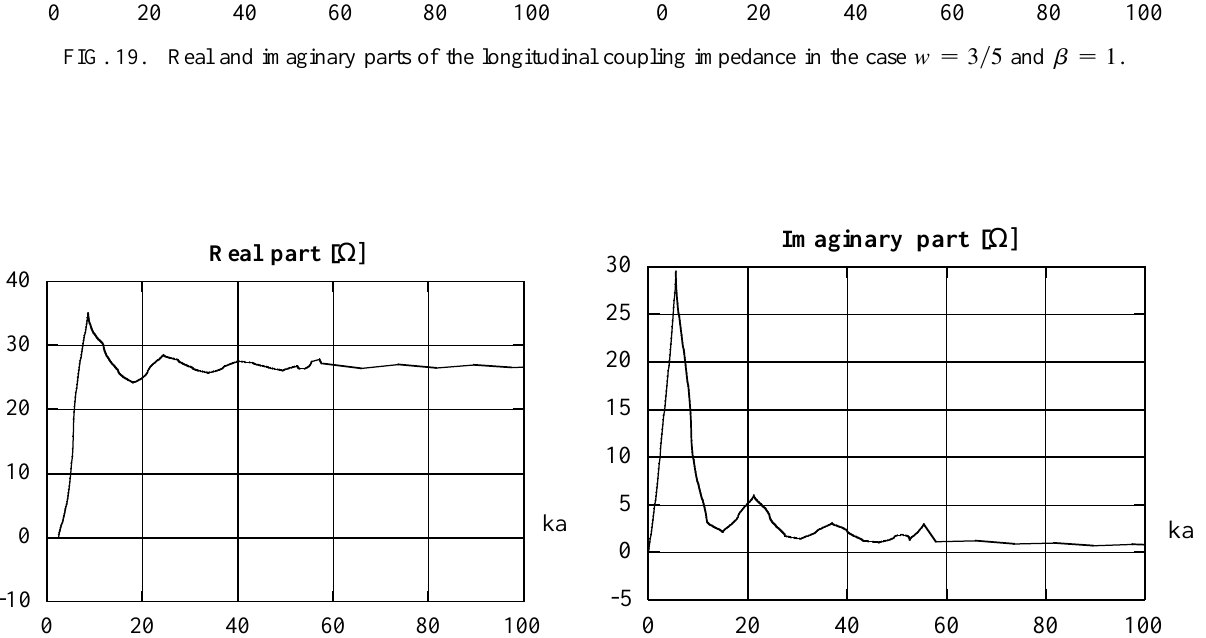
FIG. 20. Real and imaginary parts of the longitudinal coupling impedance in the case (cid:119) (cid:173) (cid:52) (cid:121) (cid:53) and b (cid:173) (cid:49)